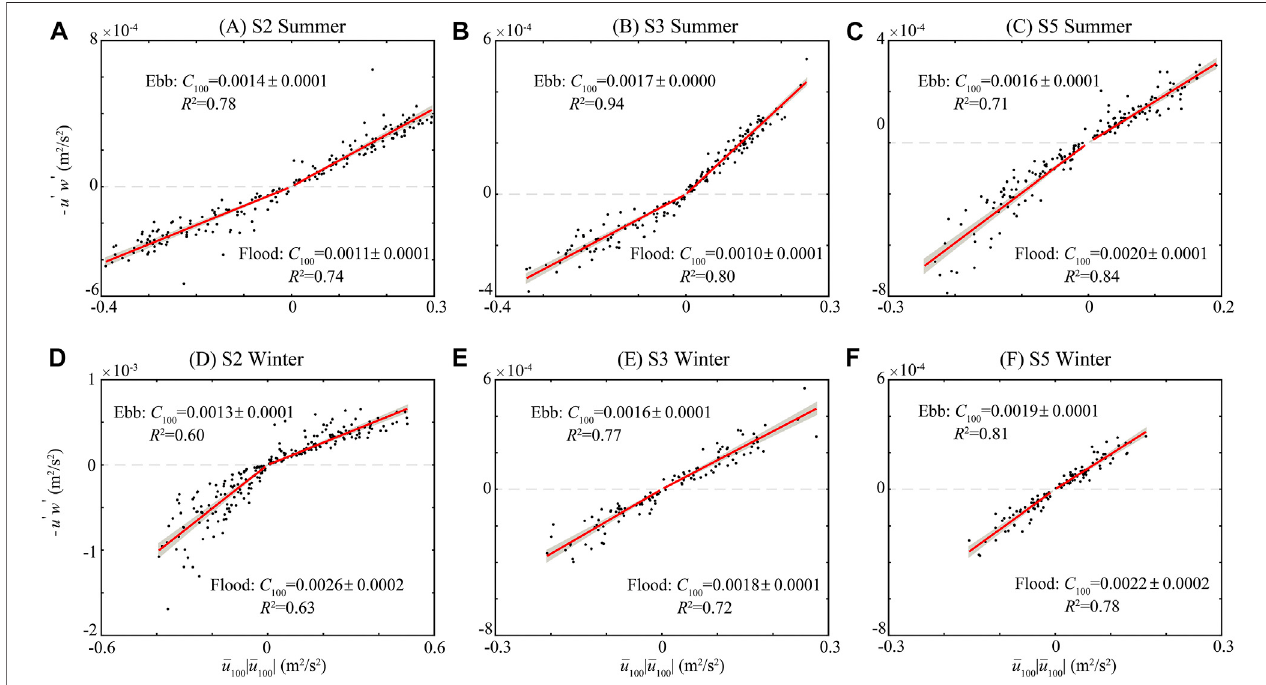
FIGURE 9 | Correlation between measured turbulent Reynolds stress, − u ′ w ′ , and the sign-preserving squared mean velocity at 1 mab, (cid:1) u 100 | (cid:1) u 100 | , for the (A,B,C) summer and (D,E,F) winter. Note that only data during calm periods (with weak waves and no sediment strati fi cation) are shown to ensure the feasibility of log law. The best fi tlinesareshowninred,withtheslopesindicatingthedragcoef fi cient, C 100 ,forebbtides(top)and fl oodtides(bottom).The95%con fi denceintervals(grayshaded areas) and R 2 are shown for each regression.